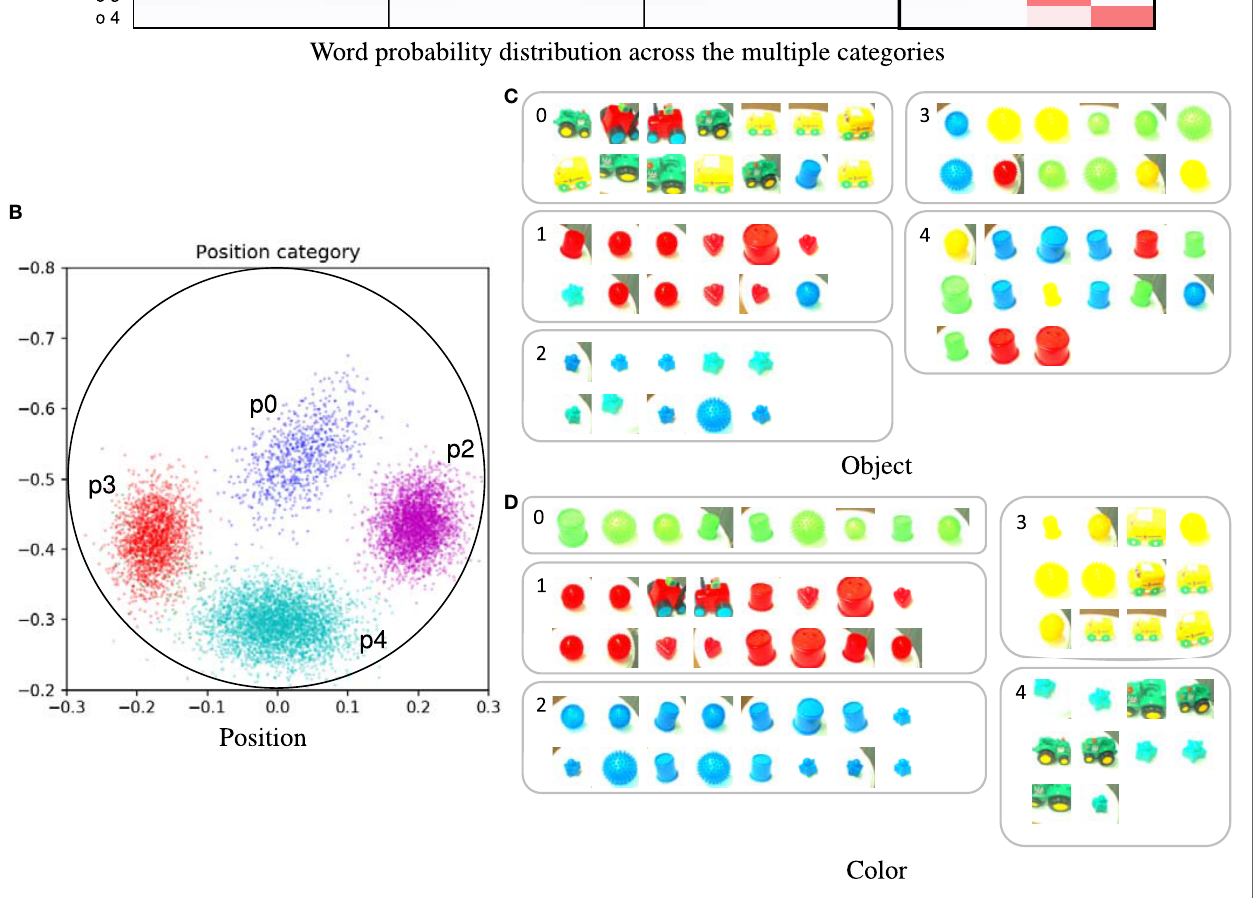
FIGURE 8 | (A) Word probability distribution across the multiple categories; (B) learning result of position category; each color of the point group represents each of the Gaussian distributions of the position category. The crosses of each color represent the object positions of the learning data. Each color represents a position category. The circle represents the area of the white circular table. (C) Example of categorization results of object category; (D) example of categorization results of color category.